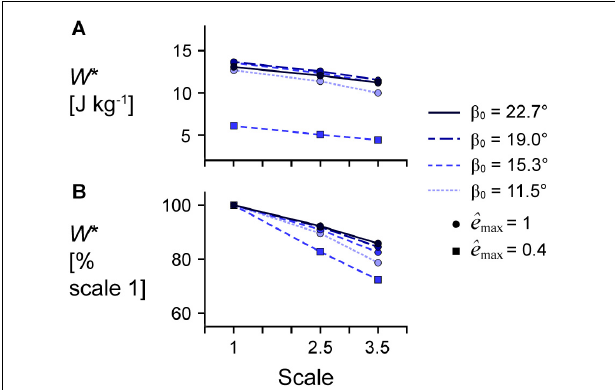
FIGURE 5 | Effect of initial pennation angle on the relationship between scale and mass-specific mechanical work. (A) Absolute mass-specific mechanical work per cycle W * across geometry length scales (muscle sizes) for different initial pennation angles β 0 ranging from 11.5 to 22.7 ◦ relative to the x -axis for maximum strain of 5% and maximum relative excitation ê max of 1 (circles) and 0.4 (squares). W * across scales as a percentage of scale 1 W * at the same β 0 and ê max are shown in (B) . All cycles had a frequency of 2 Hz. Note that the lines connecting discrete points are intended to aid in visualization rather than to imply a linear relationship.